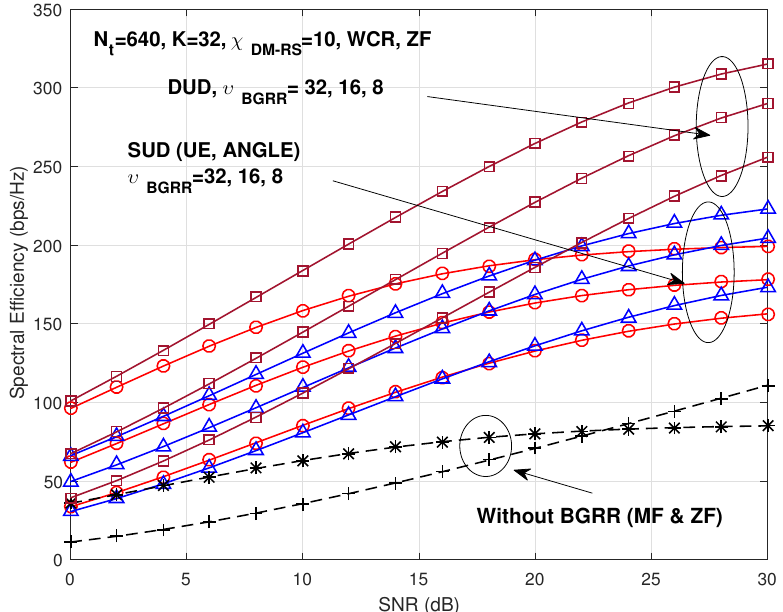
Figure 11. SE (bps/Hz) versus SNR (dB), when N t = 640, K = 32, χ DM − RS = 10, υ BGRR = 32,16,8, ZF group precoding. Red solid lines with ’ O ’ marks are the UE based grouping and blue solid ’ (cid:52) ’ marks are the angle based grouping.